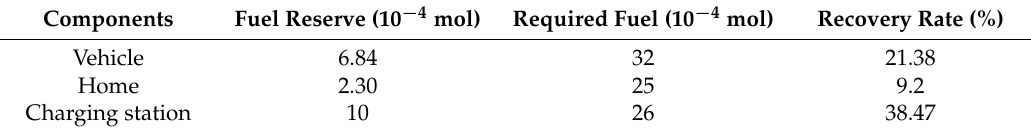
Table 5. H 2 fuel distribution.